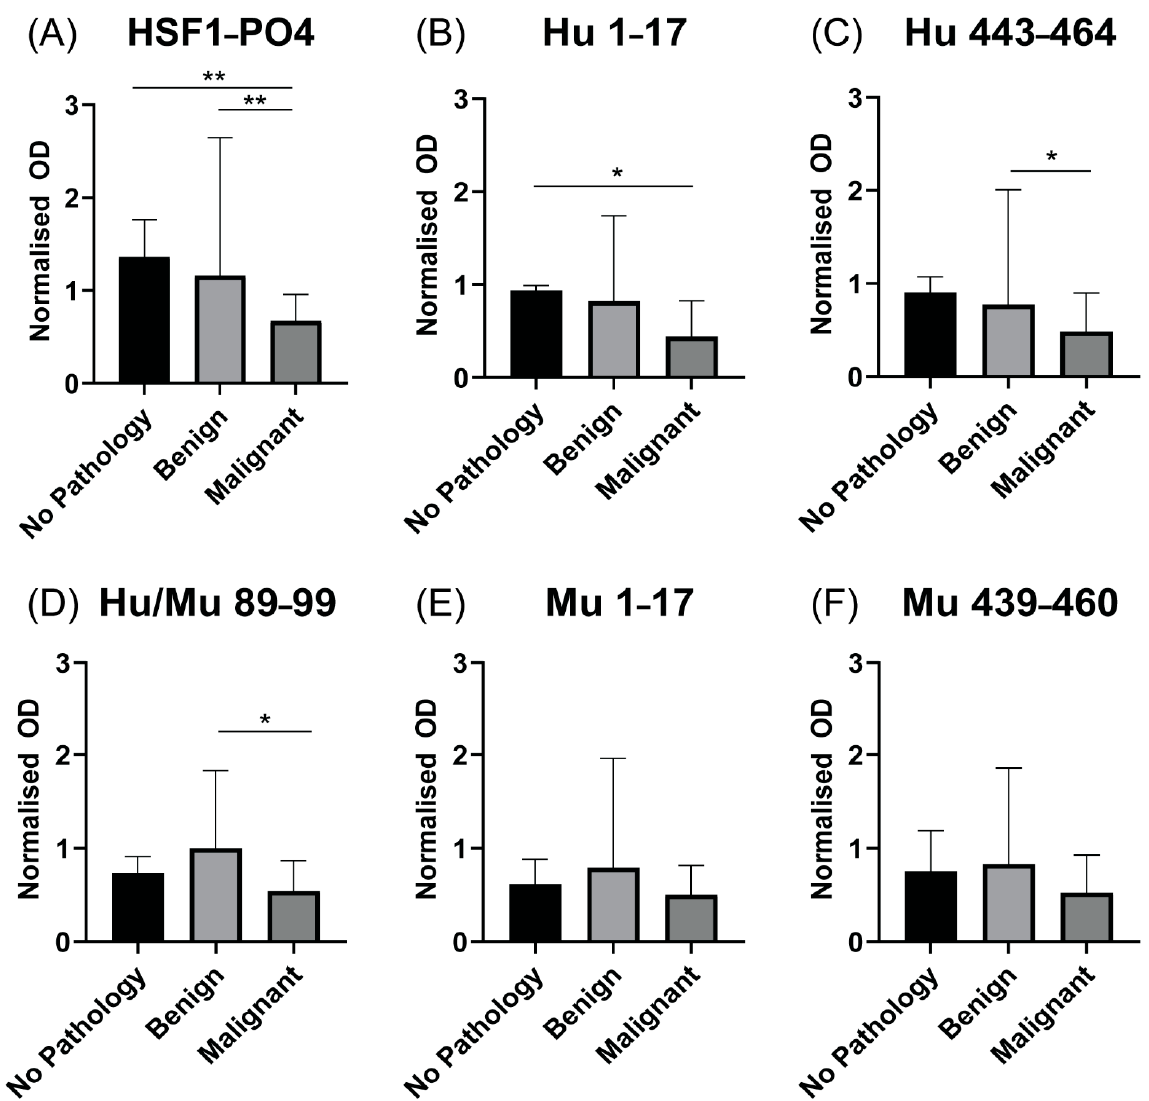
Figure 6. IgA-specific antibodies against ( A ) HSF1-PO4 and ( B – F ) predicted epitopes measured via indirect ELISA. Serum samples (diluted 1:10) from Cohort 2 patients (no pathology n = 11, benign n = 9 and malignant n = 23), where